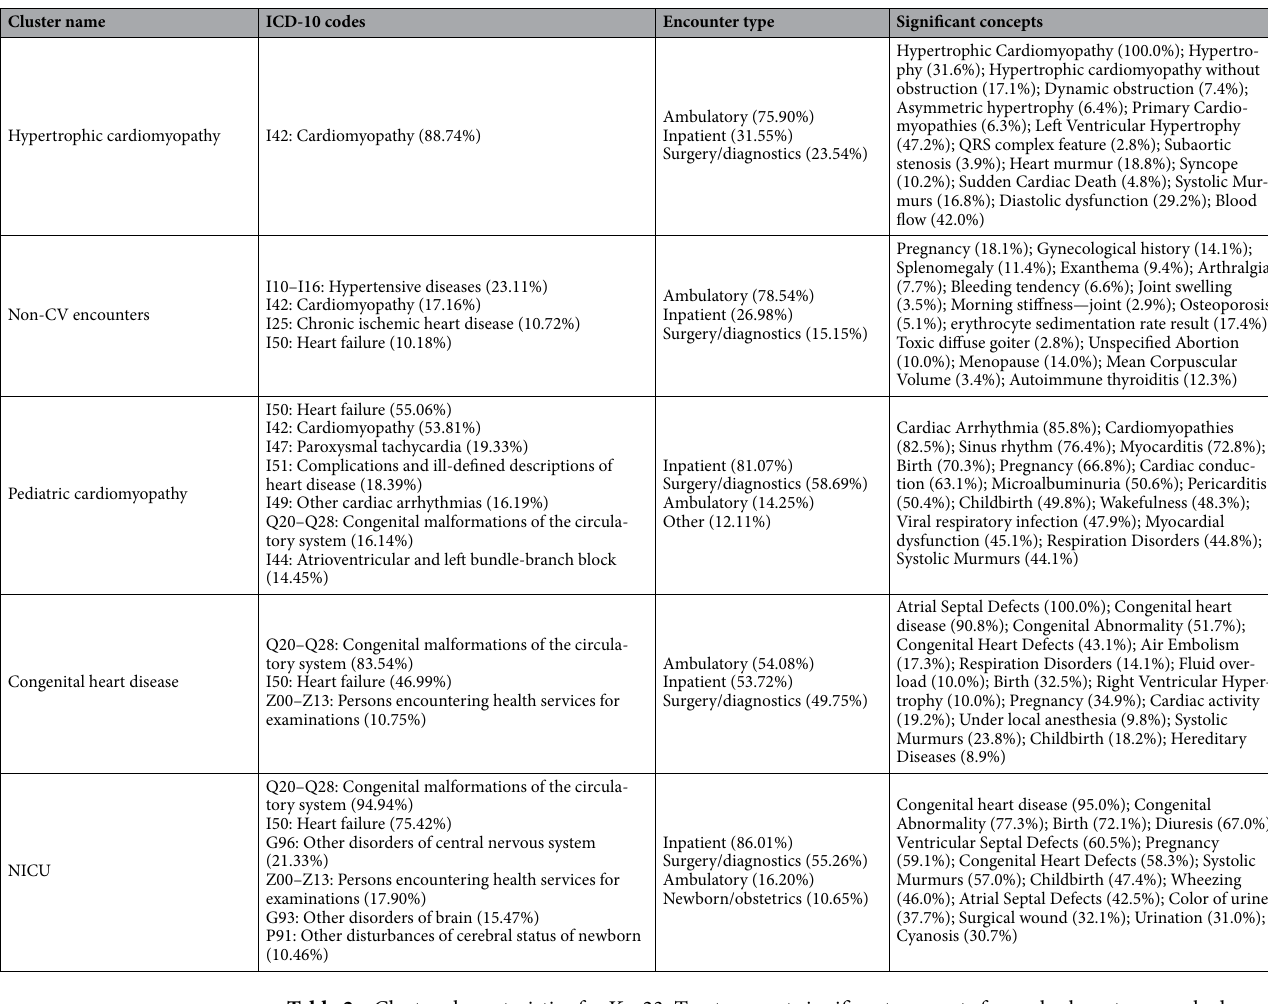
Table 2. Cluster characteristics for K = 23. Top ten most significant concepts for each phenotype, ranked by p-value (smallest to largest). Significance was determined using a one-sided (greater) sum of ranks test with Bonferroni correction testing the null hypothesis that the distribution of values of TF-IDF features for a medical entity in cluster i are drawn from the same distribution as the same entity in all other clusters. The “ICD-10” column shows the six most frequent ICD-10 codes and/or groups of codes with more than 5% incidence within the cluster. The “Encounter type” column shows the types of encounters that comprise the snapshots within each